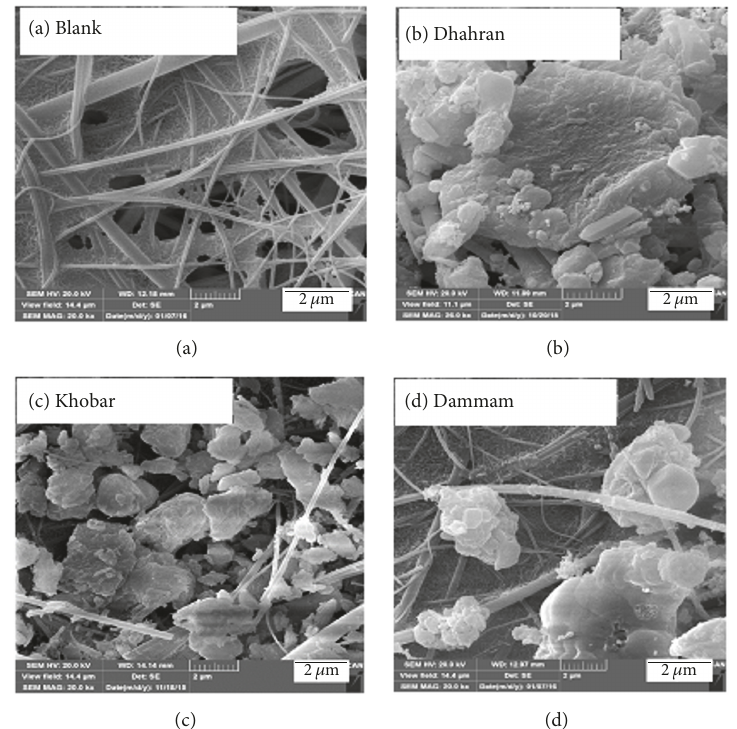
Figure 4: FESEM image analysis showing the morphology of PM 10 samples (a) blank filter, (b) Dhahran, (c) Khobar, and (d) Dammam.